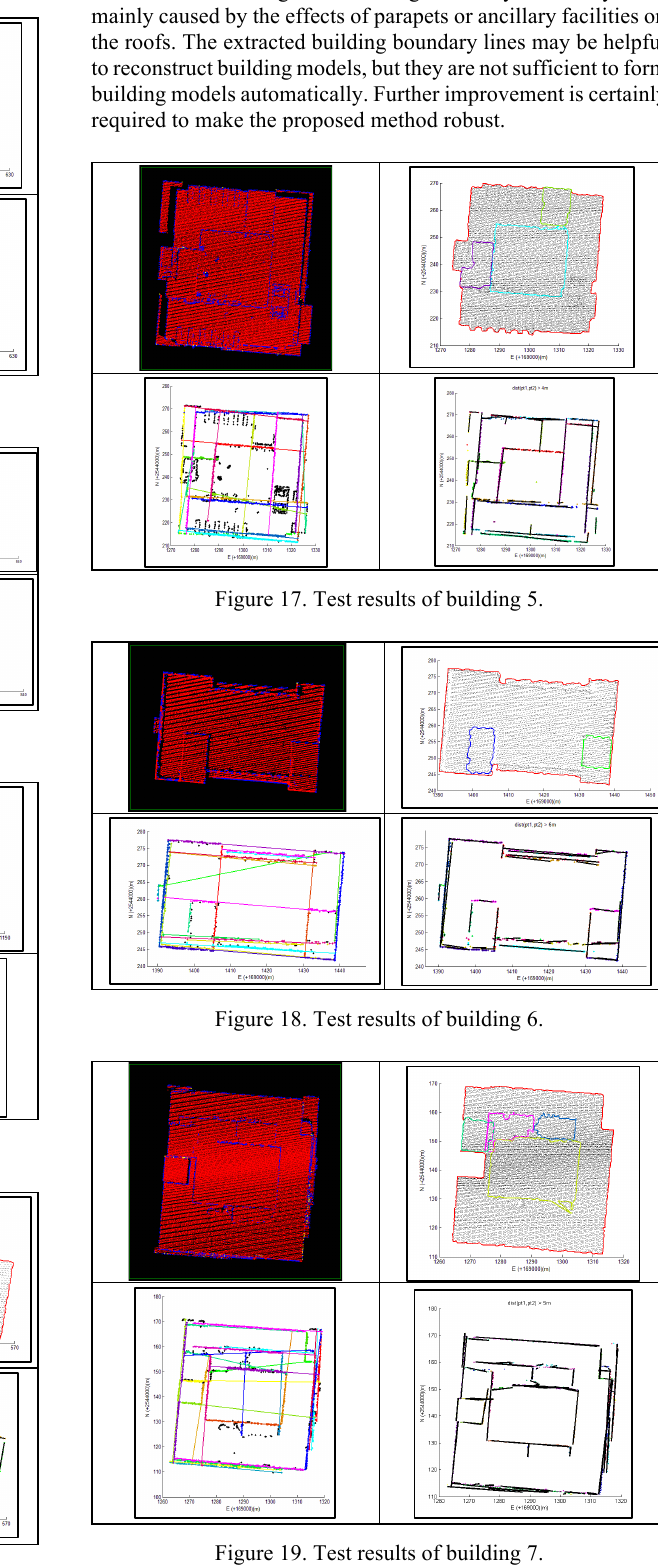
Figure 16. Test results of building 4.